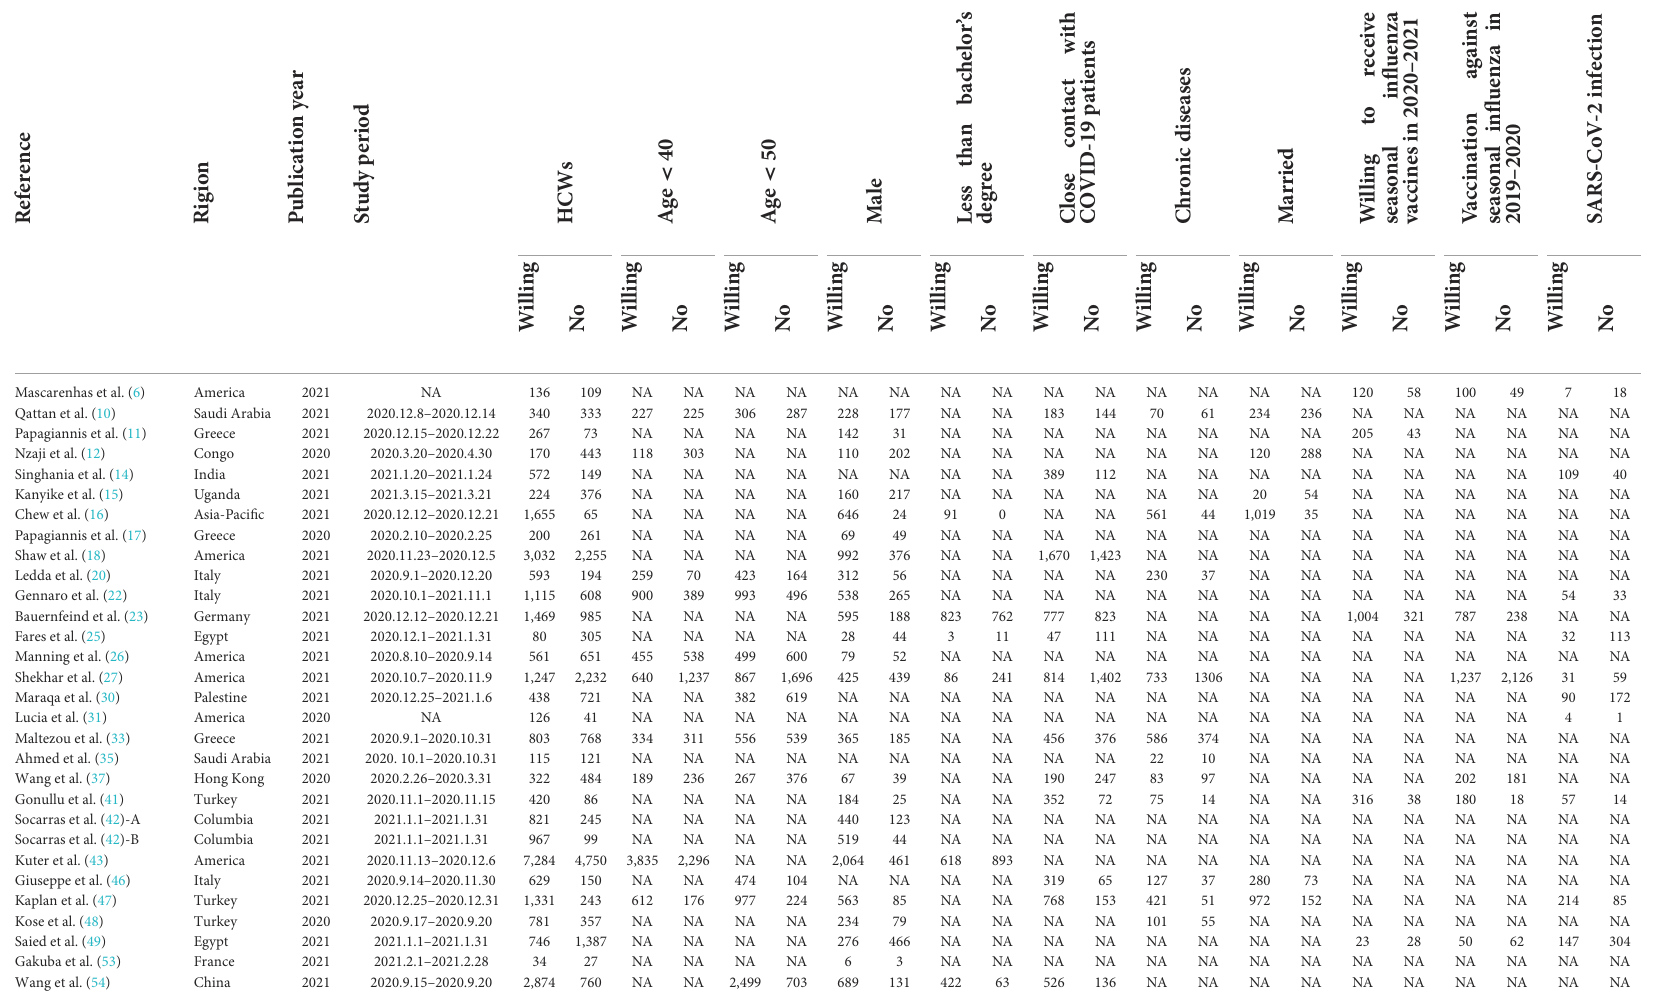
TABLE 2 The characteristics of HCWs who are willing and unwilling to receive coronavirus disease 2019